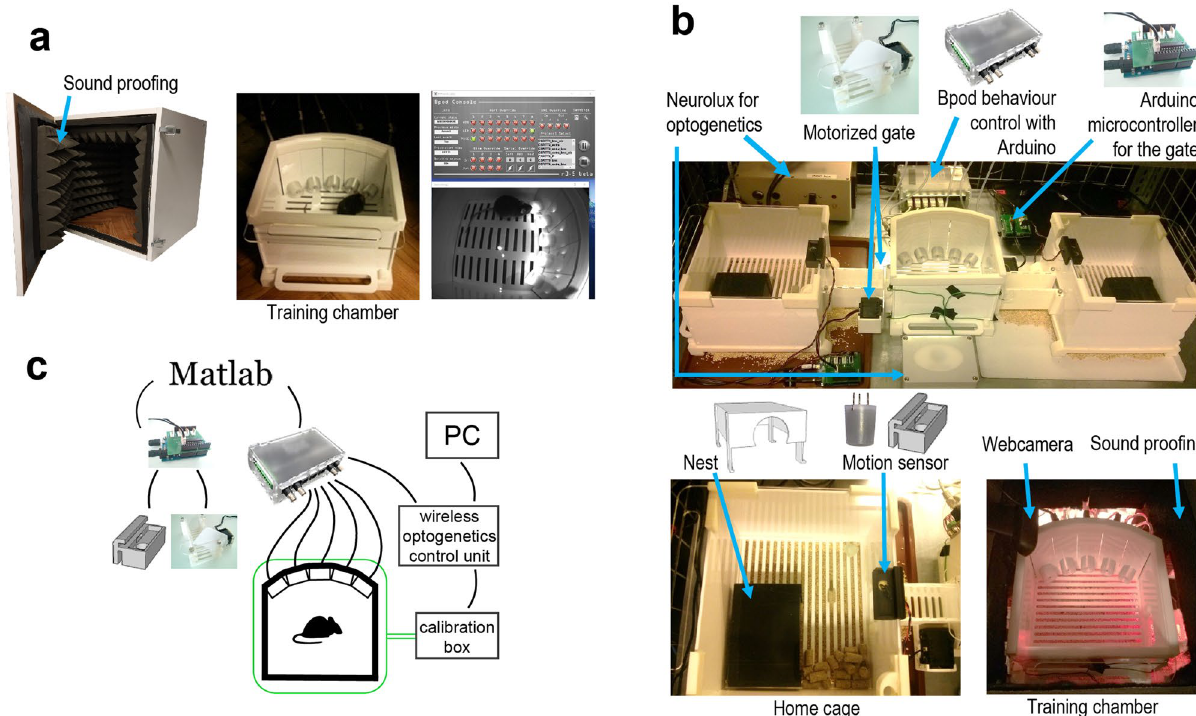
Figure 1. Behavioral setup. ( a ) Manual training setup. Left, the training chamber was placed in a sound attenuated wooden box (60 × 60 × 60 cm). Middle, the training chamber housed five behavior ports (Sanworks) each with an infrared photogate, a liquid reward tube and a visible (white) LED. Right, the behavior ports were controlled by the Bpod behavior control unit (Sanworks) during training (top), while the animal was monitored via a high definition camera (FlyCapture; bottom). ( b ) Automated training setup. The ATS (top) consisted of a training chamber (bottom right) identical to that of the manually trained animals except for the side openings, through which it was connected to home cages (bottom left) on both sides. The home cages were equipped with a 15 × 5 × 2 cm 3D-printed box filled with nesting material serving as nest for the animals, and a motion sensor (Panasonic) attached to the roof. The home cages were connected to the training chamber via tunnels blocked by Arduino-controlled motorized gates. The equipment for wireless optogenetics (Neurolux) and